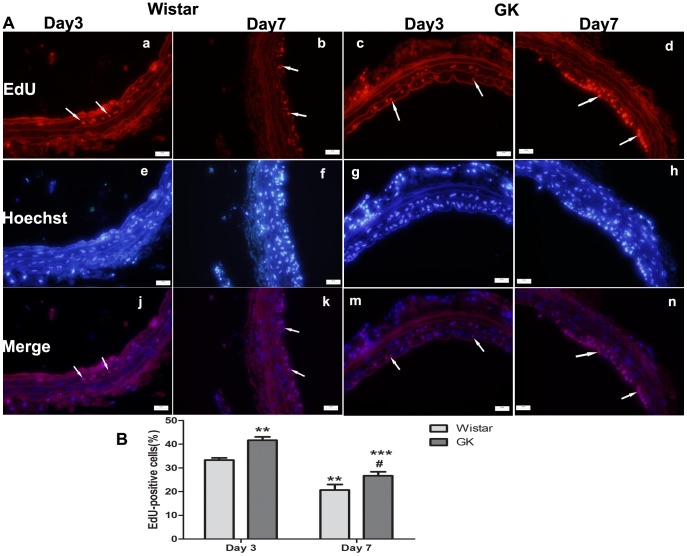
Representative images of EdU staining of common carotid arteries in Wistar and GK rats (400×).EdU staining (A–a, b, c, d), Hoechst33342 staining (A–e, f, g, h), images of merging EdU staining and Hoechst33342 staining (A–j, k, m, n). Percentage of EdU-positive cells of Day 3 post-injury were more than those of Day 7 post-injury in both rats and percentage of EdU-positive cells in GK rats were more than those in Wistar rats (B). Data are represented as mean ± SEM. **indicates versus Day 3 post-injury, p<0.01, ***p<0.001; #indicates versus Day 7 post-injury, p<0.05.